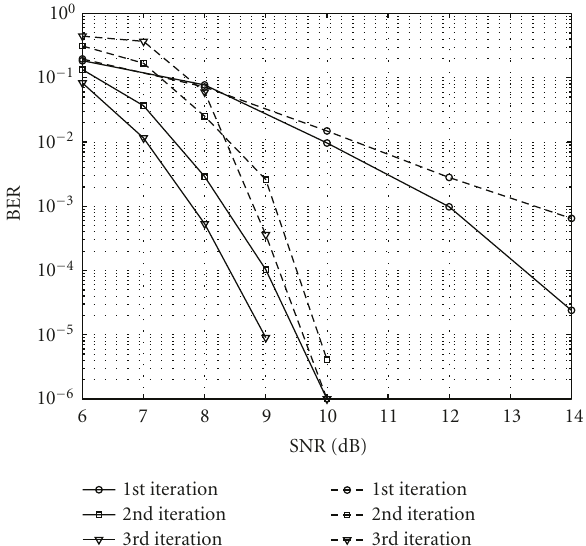
Figure 9: Performance of conventional noniterative receiver for varying number of feedback taps.